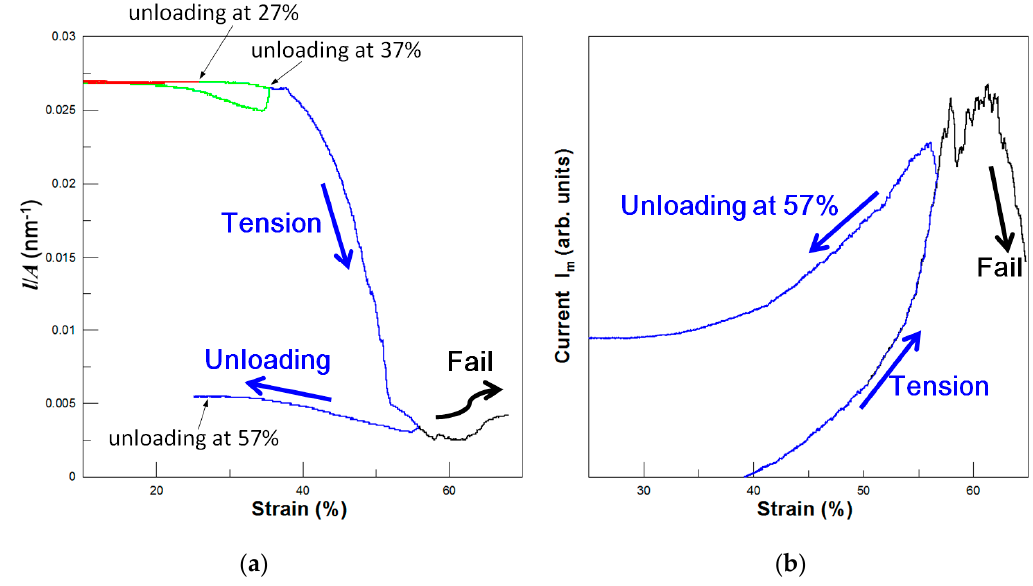
Figure 18. Resistance and current versus strain of SiNW ( a ) resistance-strain curves; ( b ) current-strain curves (unloading at strain of 27%: red; 37%: green; 57%: blue; without unloading: black).